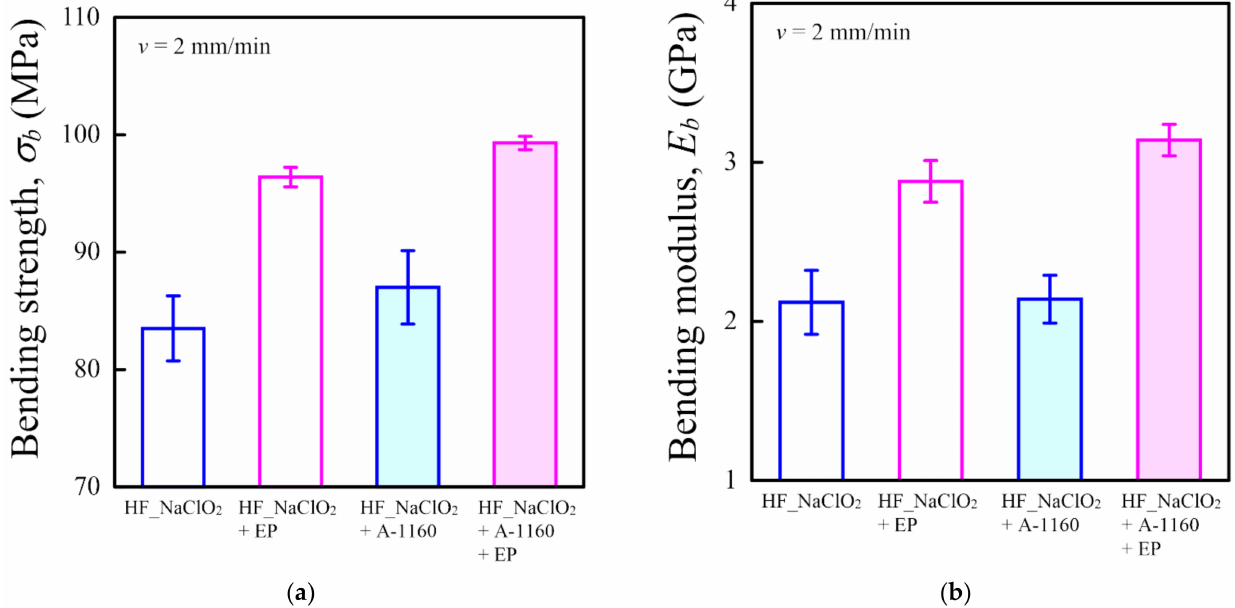
Figure 6. Bending properties of various surface-treated HF/PA1010 biomass composites: ( a ) bending strength σ b and ( b ) bending modulus E b